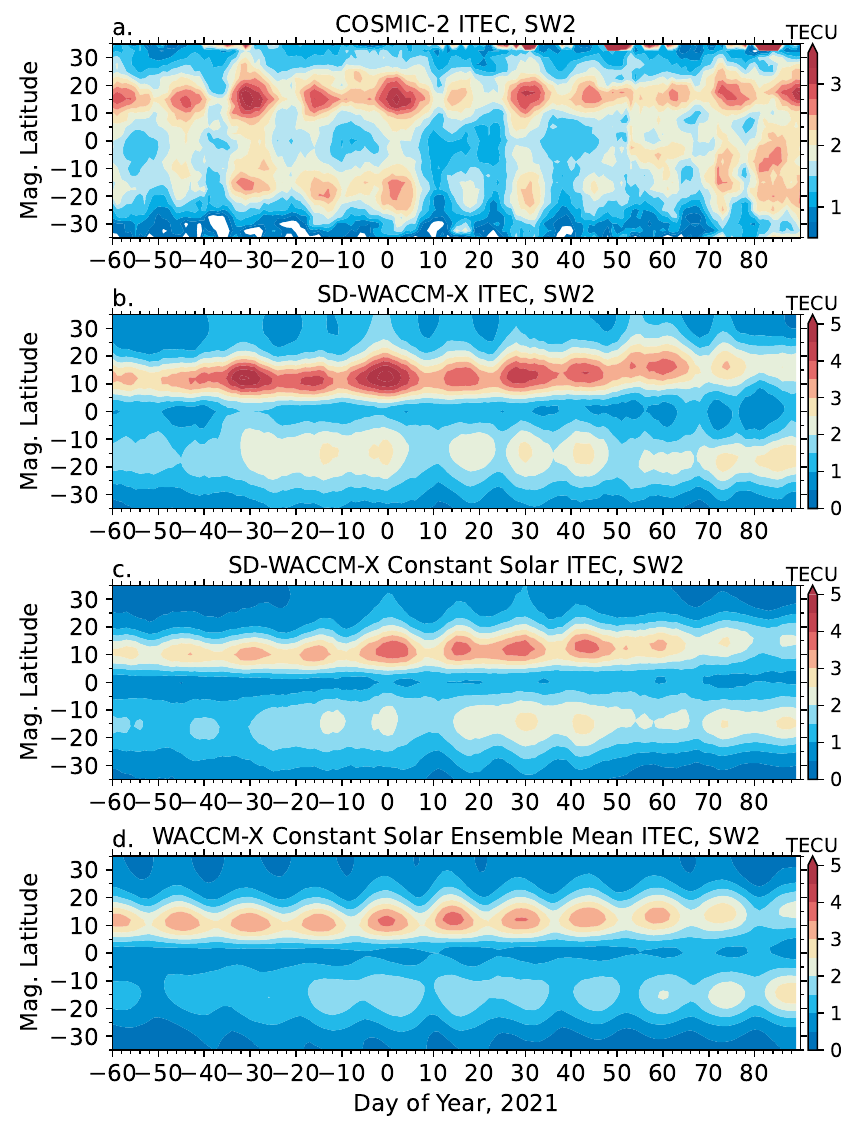
Figure 5. SW2 amplitude in ITEC from ( a ) COSMIC-2 observations, ( b ) SD-WACCM-X, ( c ) SD- WACCM-X Constant Solar, and ( d ) WACCM-X Constant Solar Ensemble Mean. Last, we discuss the variability in the semidiurnal nonmigrating tides SW1 and